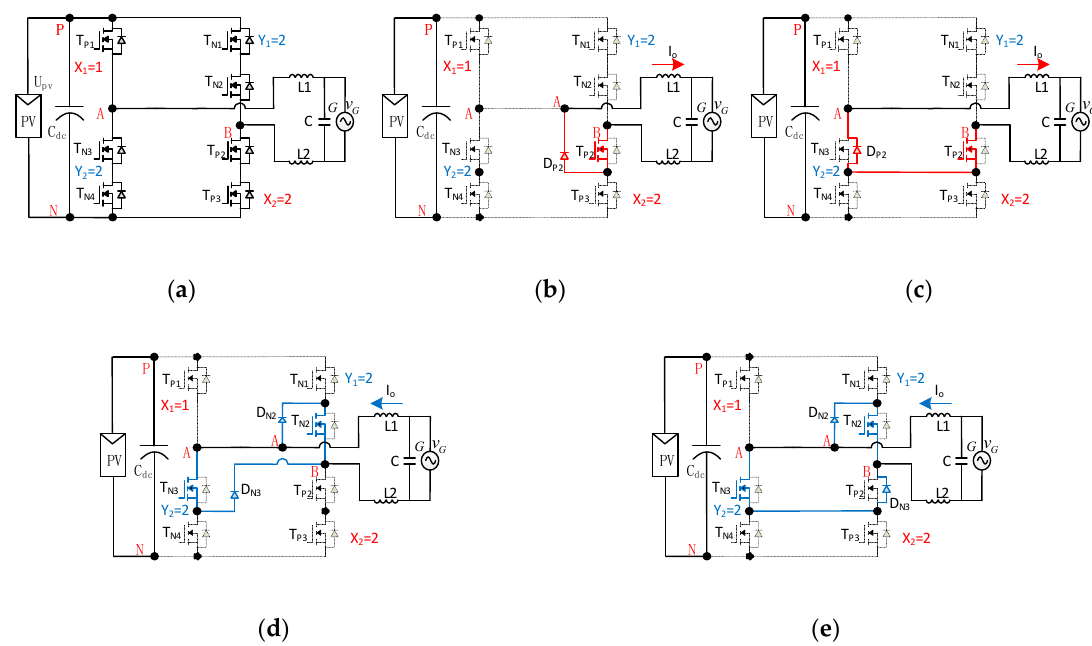
Figure 15. Four modes under X 1 = 1, X 2 = 2, Y 1 = 2, and Y 2 = 2. ( a ) PC and NC modes; ( b ) PF mode #1; ( c ) PF mode #2; ( d ) NF mode #1; ( e ) NF mode #2.